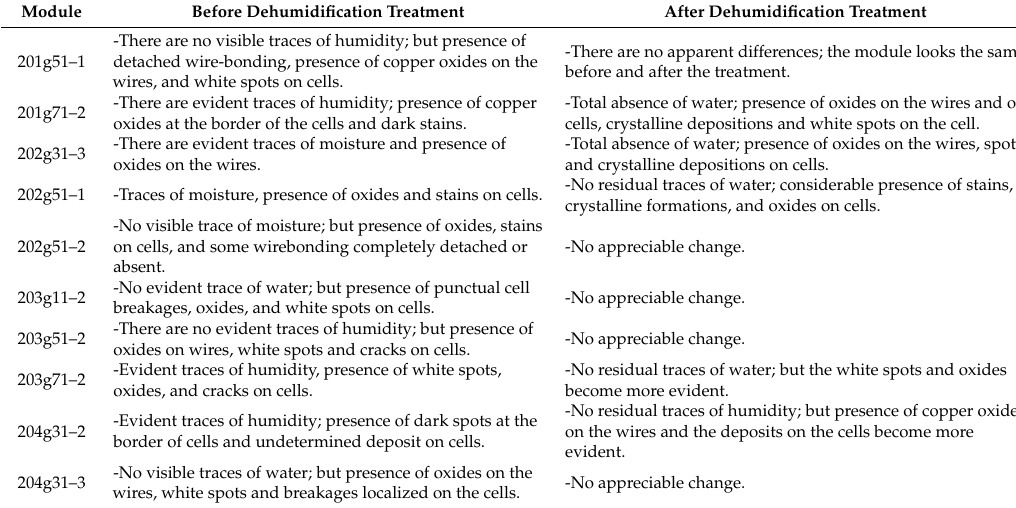
Table 1. Visual observation of the ten selected